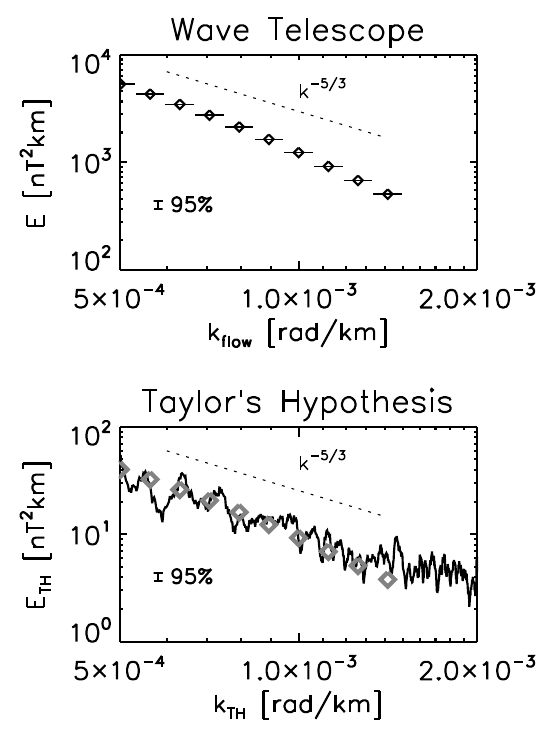
Fig. 5. Comparison of the wave number spectra. The upper panel is the energy spectrum for the wave number in the flow direction, reduced from the 3-D energy distribution using Cluster data and the wave telescope technique. The lower panel displays the energy spectrum transformed from the frequency into the wave number do- main using Taylor’s hypothesis (solid line) and the reduced spec- trum shown in the upper panel (squares) with adjustment for com- parison of the spectral